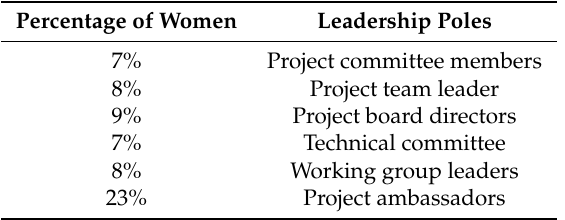
Table 4. Leadership roles of women in open software development projects [13].